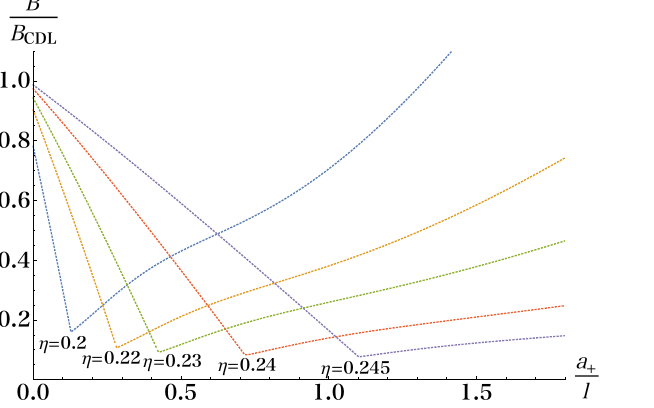
Figure 5 . Plots of the e(cid:11)ective potential U ( R 0 ) with 8 G 5 M + = 3 (cid:25)l 2 = 4 = 100 ; (cid:14) = 2 = 10 and 1 = 10. The curves from the bottom to the top correspond to (cid:15) = 1 = 10, 1 = 30, 1 = 100, 1 = 500 and 1 = 5000, respectively.